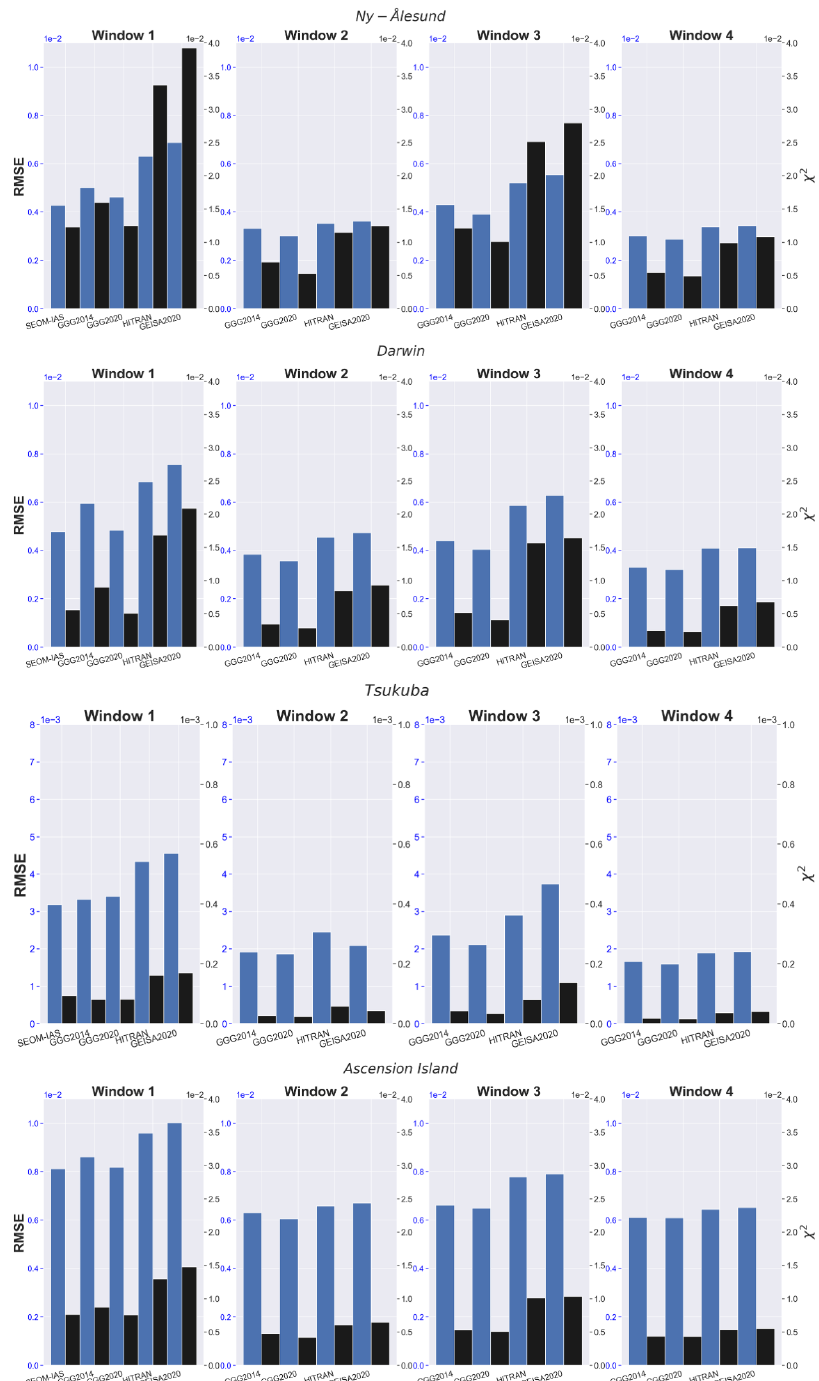
Figure 2. Bar charts indicating the fit statistics for a selection of retrievals from each of the TCCON sites. Each row of the figure refers to results from one of the TCCON sites, indicated by the row title. Each column shows the results from one window, indicated by the title of each column. Each subplot shows the RMSE and χ 2 values for each spectroscopic database indicated on the x axis, with the blue bars referring to the RMSE values, with magnitudes shown on the left-hand y axis. The black bars refer to the χ 2 values, with the magnitudes indicated on the right-hand y axis. Note the scale on the Tsukuba row is slightly different to account for the lower-magnitude results. Cross sections of 500 spectra for each TCCON site are used to generate the statistics in this